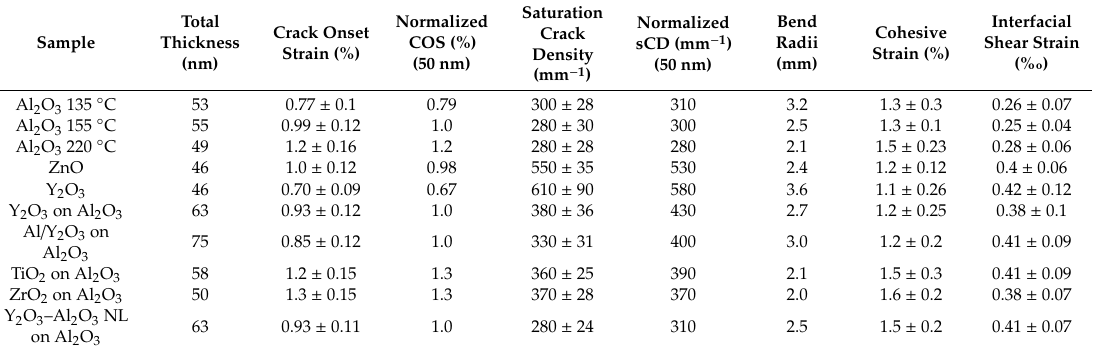
Table 2. Crack onset strain, saturation crack density, critical bending radius, cohesive strain, and interfacial shear strain for the studied samples. Thickness-normalized crack onset strains (COS 50 nm) and saturated crack densities (sCD 50 nm) relate to the total film thickness including the interfacial Al 2 O 3 layer when applicable. Uncertainties include sample variations, fitting residuals, and measurement accuracies. The data represent an average over 5–6 tensile measurements for each